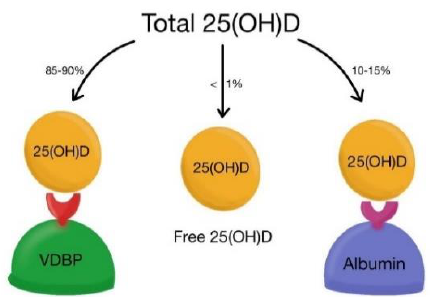
Figure 3. Total 25(OH)D in serum is bound to vitamin D binding protein (VDBP), 85 – 90%; albumin, 10 – 15%; and <1% circulates free. Bioavailable vitamin D refers to vitamin D3 and D2, which are not bound to VDBP (Adapted from Fernando M, [31]).